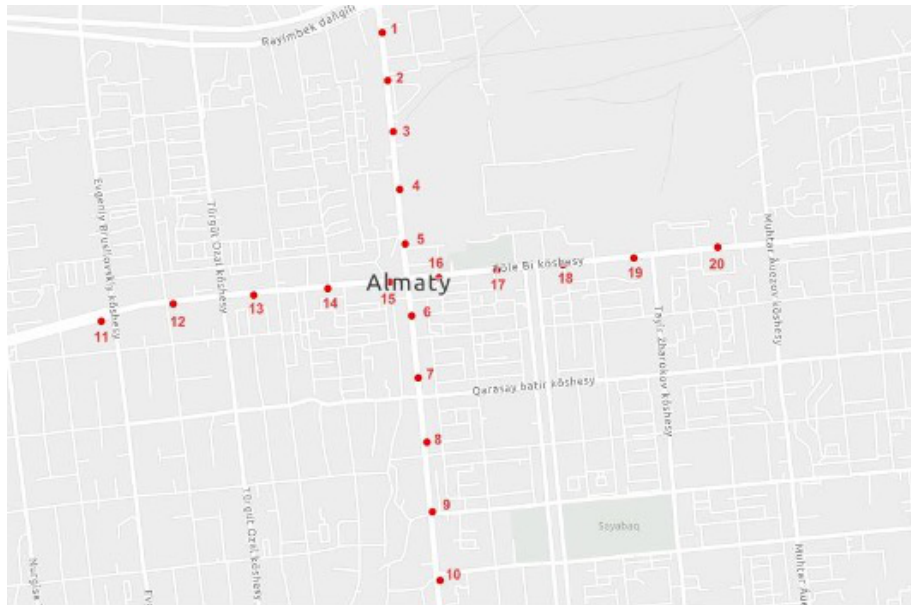
Figure 1: Location of the investigated stations in the center of